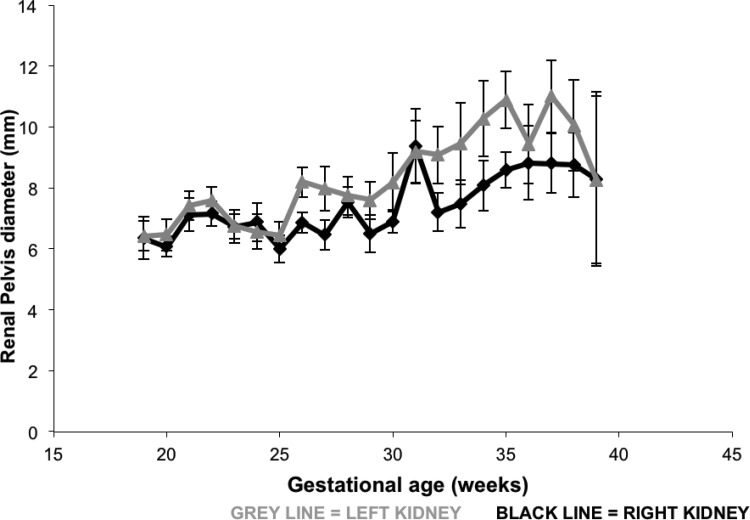
Mean profiles and standard errors of the RP diameters according to gestational age.